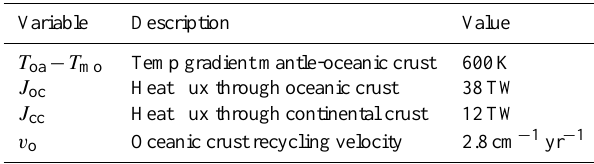
Table 4. Values for oceanic crust recycling when “diffusion” pa- rameter γ =1.5 × 10 − 11 which produces maximum rates of power generation (and dissipation and so